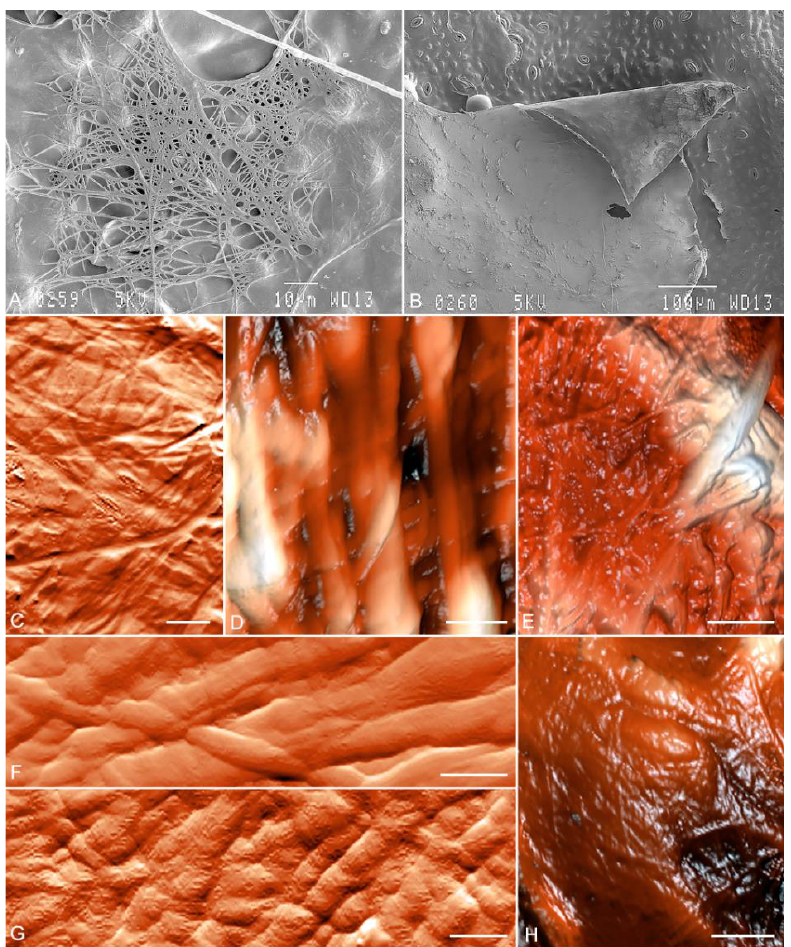
Figure 9. LT-SEM images ( A , B ) and AFM topographical scans ( C – H ) of young ( A ) and mature ( B – H ) web produced by Aberoptus schotiae n. sp. Scale bar: ( A ) = 10 μm; ( B ) = 100 μm; ( C – G ) = 1 μm; ( H ) = 5 μm.